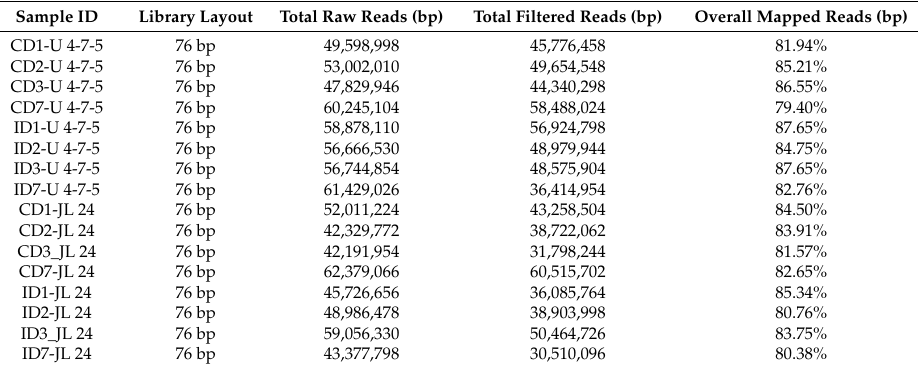
Table 1. Summary of sequencing data generation and mapping to transcriptome